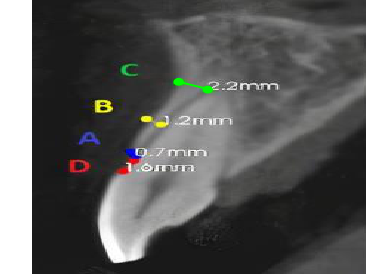
b: Measurement of the alveolar height: 1. Nasal fossa Floor 2. Alveolar hight 3. Alveolar Crest Fig. 1. Measurements protocole on oblique CBCT reconstructions.